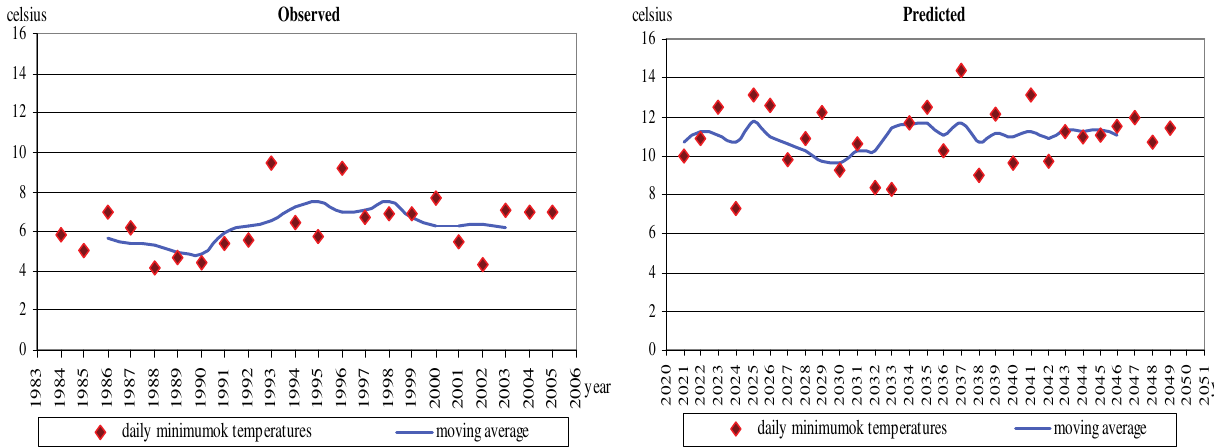
Figure 3: The observed (Left) and estimated (Right) daily minimum temperatures at Újfehértó, estimation have been made by means of the RegCM 3.1 model for the period 10 days before bloom plus blooming time